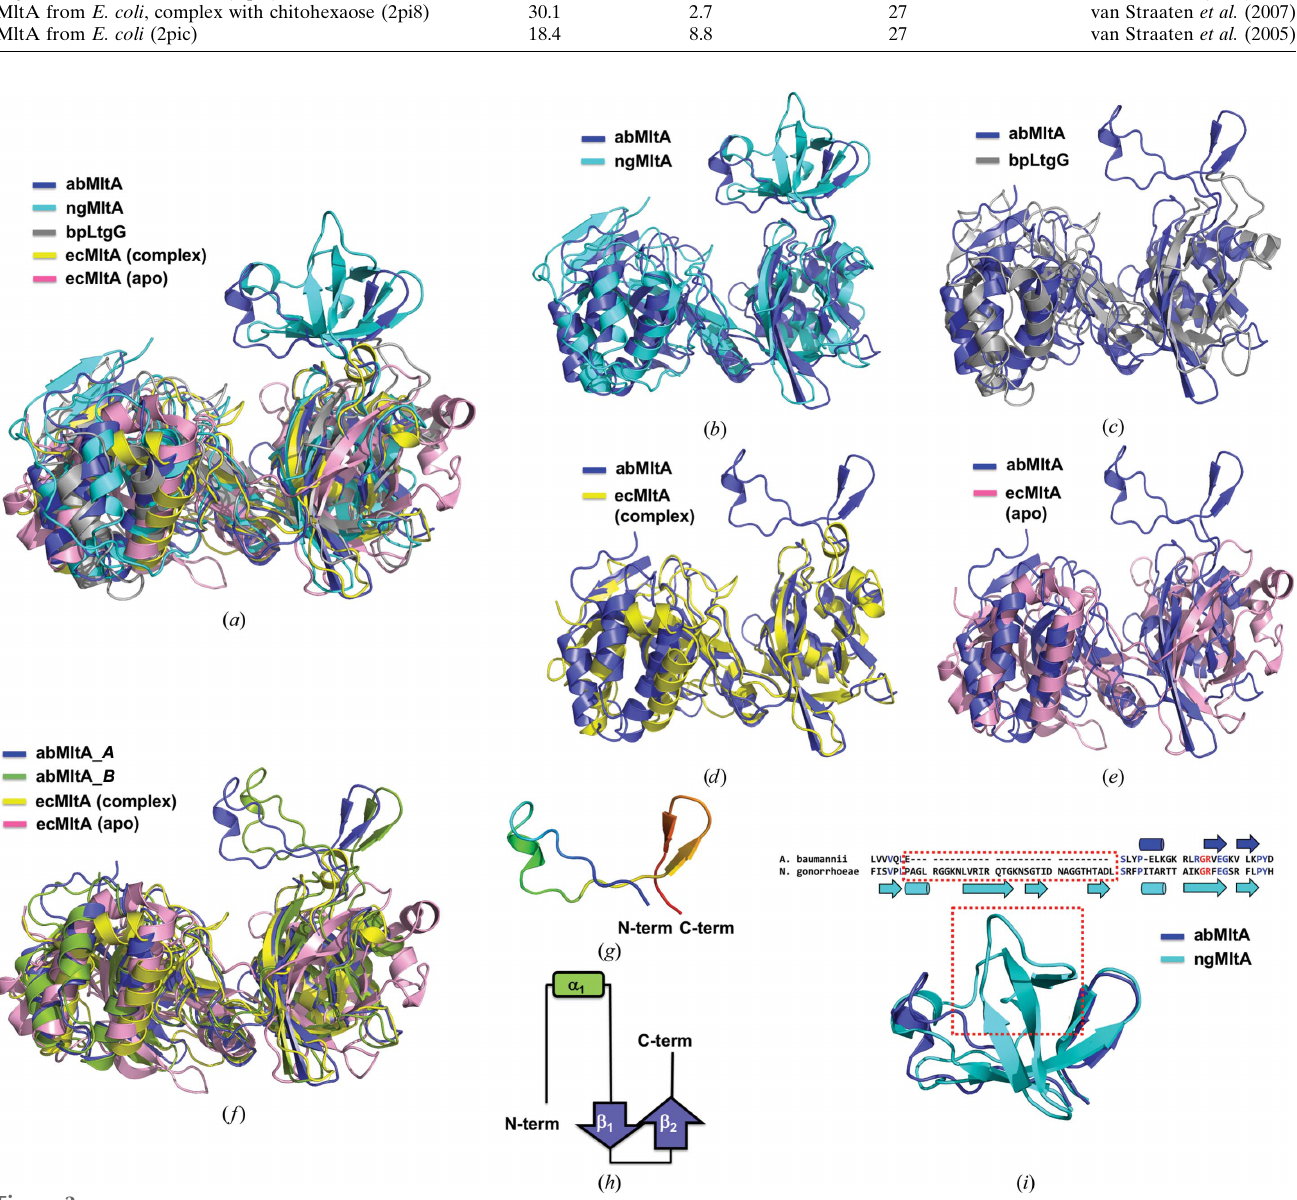
Figure 3 Structural comparison of abMltA with MltA enzymes from different species. ( a ) Structural comparison of abMltA with other orthologs. Currently available structures of MltAs from N. gonorrhoeae (ngMltA; PDB entry 2g6g), B. pseudomallei (bpMltA; PDB entry 6qk4) and E. coli (ecMltA; PDB entry 2pi8 for the complex structure with a substrate analog and PDB entry 2pic for the apo structure) were superimposed with the structure of abMltA. ( b – e ) Pairwise structural superimposition of abMltA with ngMltA ( b ), bpLtgG ( c ), ecMltA (complex structure) ( d ) and ecMltA (apo structure) ( e ). ( f ) Structural comparison of both chains of abMltAwith closed and open forms of ecMltA demonstrated by superimposition. ( g ) The structure of the extra domain of abMltA. The chain is colored blue to red from the N-terminus to the C-terminus. ( h ) Topological representation of the extra domain of abMltA. N-term and C-term indicate the N-terminus and C-terminus, respectively. ( i ) Structural and sequence comparison of the extra domain of abMltAwith that of ngMltA by superimposition. The red dotted box indicates the additional residues and structure in ngMltA. Secondary structures are presented with cylinders for (cid:3) -helices and arrows for (cid:2) -sheets. Completely conserved residues are colored red.